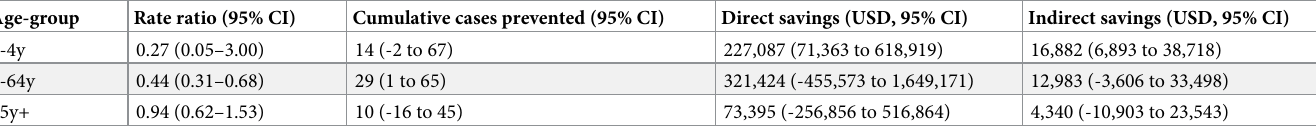
savings are presented in constant 2015